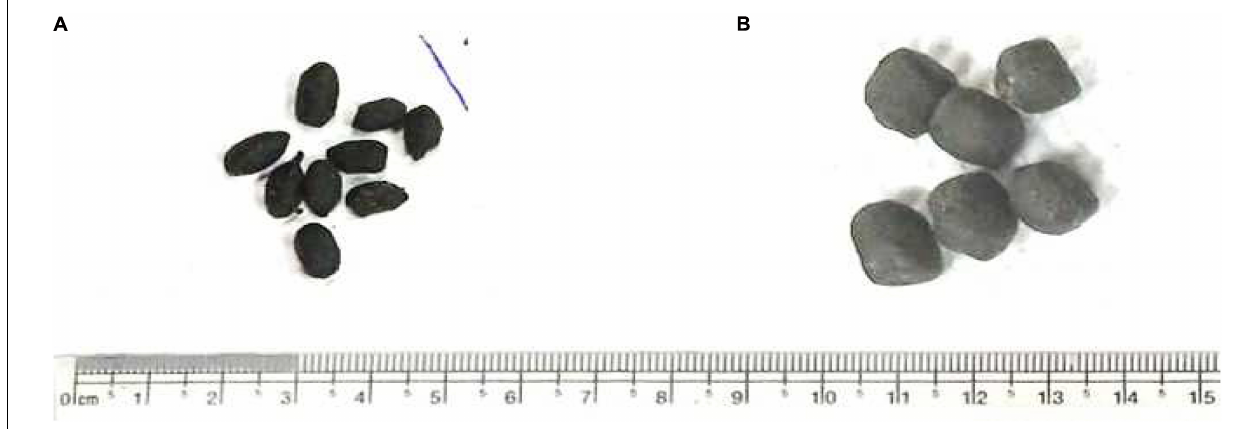
FIGURE 2 | Photographs of fecal pellets of (A) musk deer and (B) goral, for size and shape